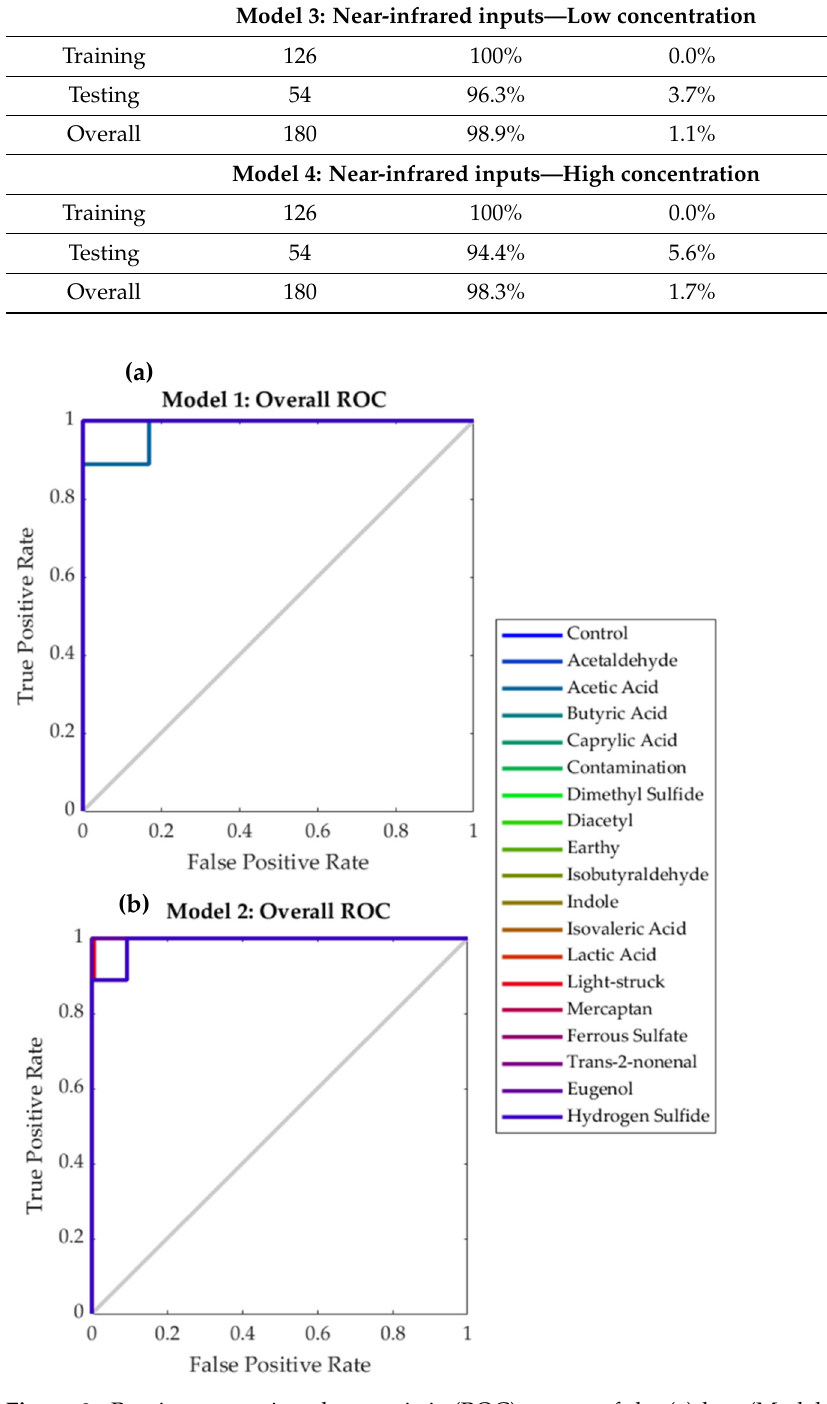
Table 4. Statistical results of the artificial neural network classification models developed using the near-infrared absorbance values as inputs. Abbreviations: MSE: means squared error.